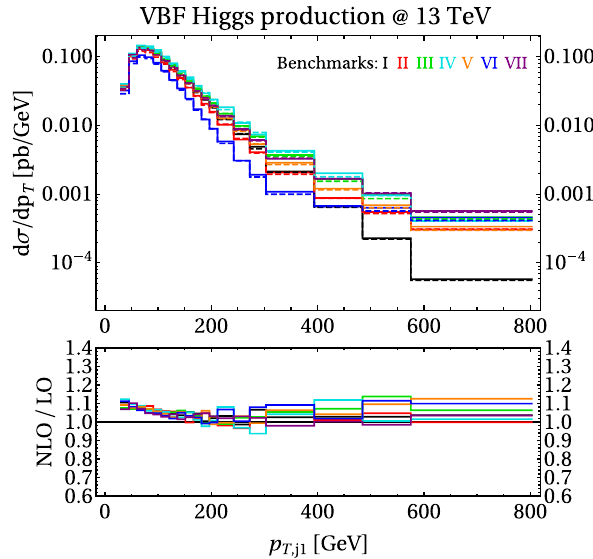
Fig. 3 Distribution of the leading-jet p T in VBF Higgs prodution events at 13 TeV. Solid (dotted) lines show NLO (LO) + PS predic- tions for seven benchmark points in the PO parameter space listed in Table